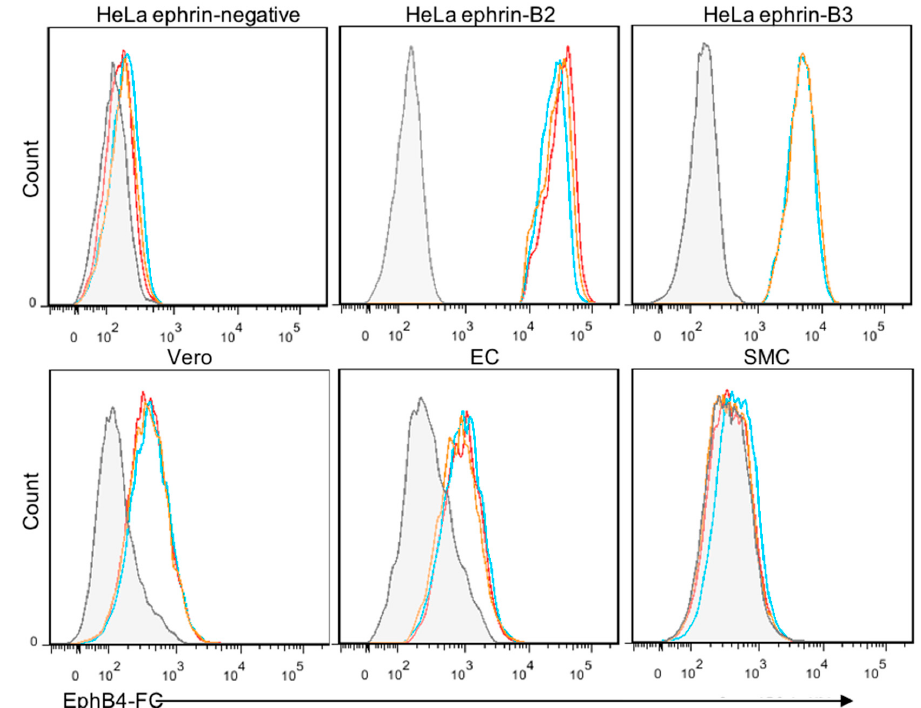
Figure 4. Expression of ephrin-B2/3 on ECs and SMCs. The respective cells were surface stained using recombinant EphB4 (the ligand for ephrin-B2/3) fused to human FC receptor (EphB4-FC), followed by an Alexa 647-conjugated anti-FC secondary antibody. Flow cytometry was performed and grey histograms show negative controls and colored lines represent stained cells from three independent experiments. HeLa cells were used as a negative control, and HeLa cells that stably express ephrin-B2 or B3 were used as positive controls for the assay.